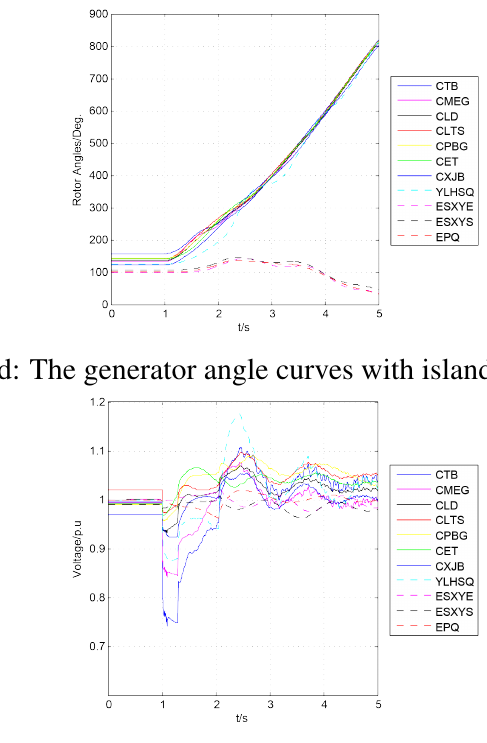
b: The bus voltage curves without islanding. d: The bus voltage curves with islanding. Figure 21.